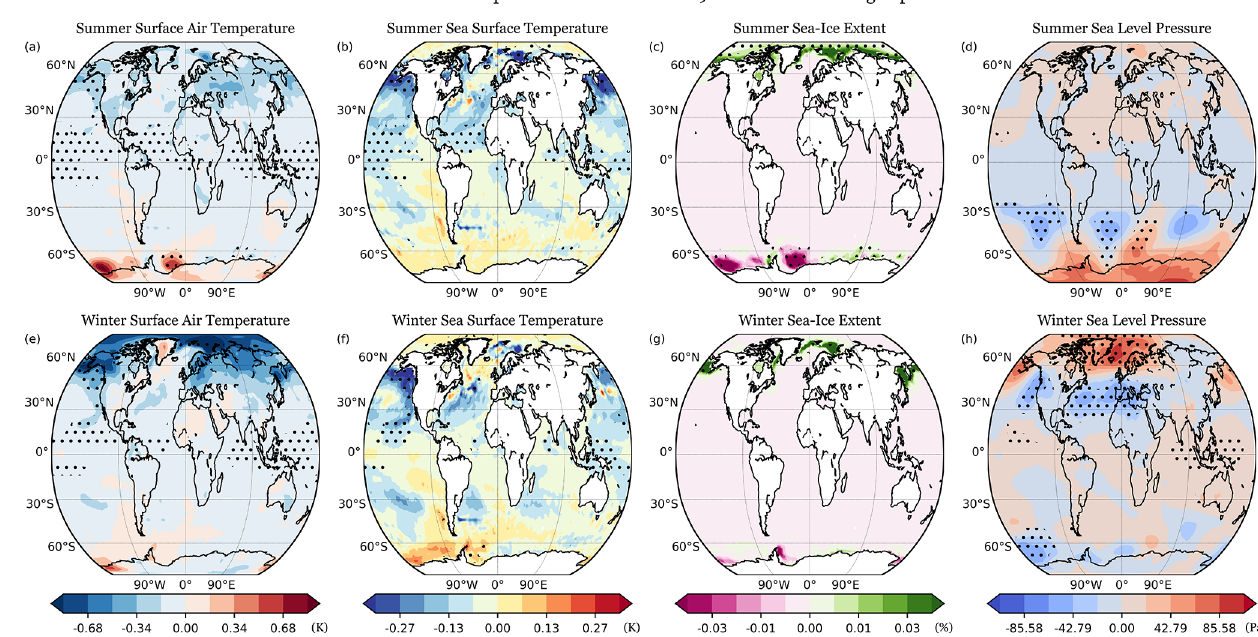
Figure 3. Ensemble mean of composite of summer (a) SAT (K), (b) SST (K), and (c) sea ice as fraction (%), and (d) sea level pressure (Pa) anomalies over 1809–1826 for the SolarStrong experiment. (e) – (h) are for winter. The black dots represent the significant grid points (see Sect. 2 for